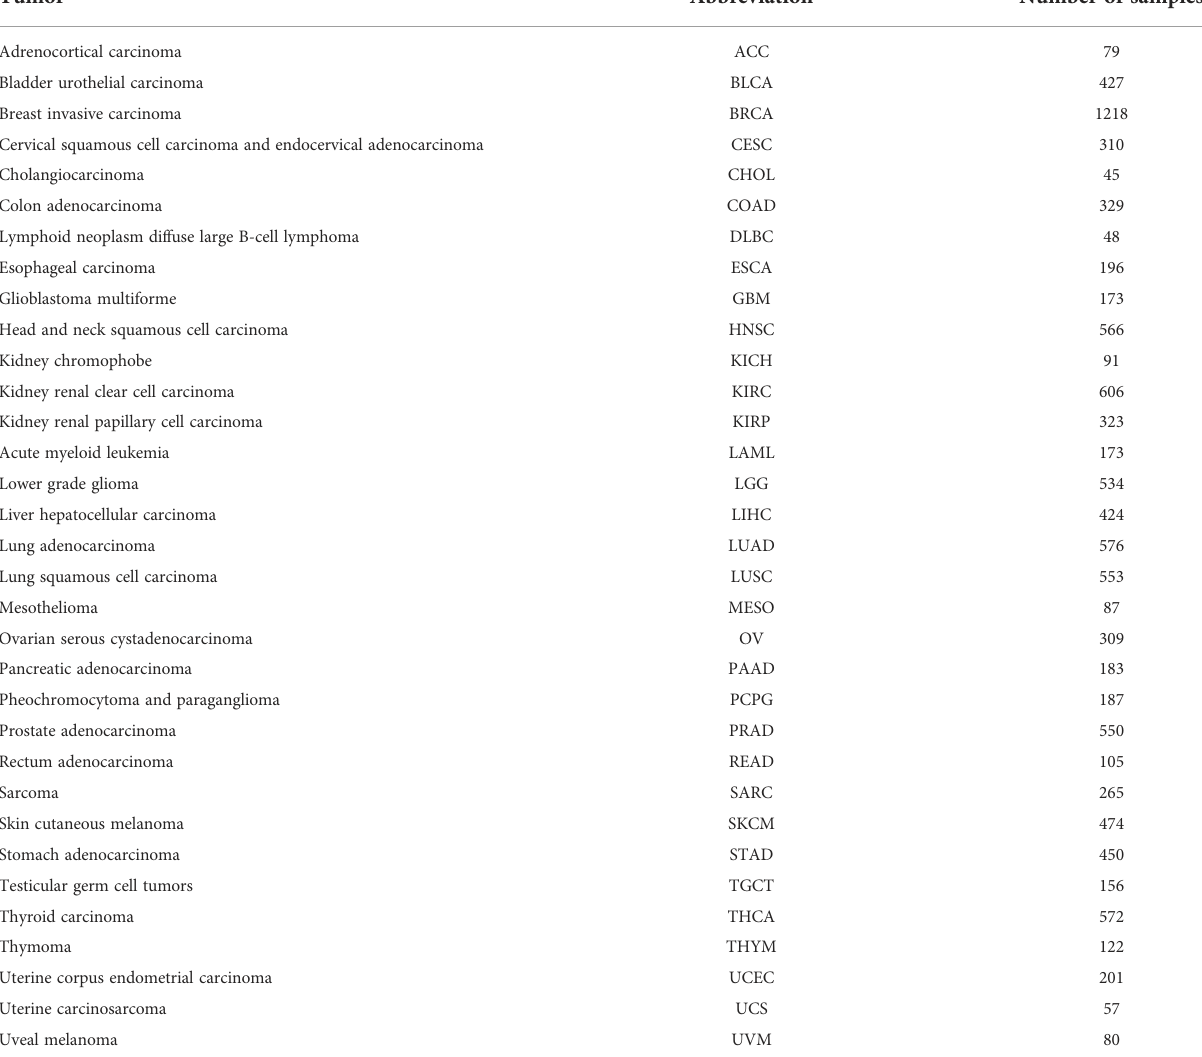
TABLE 1 The number of samples and abbreviations for the 33 types of tumors explored in this study.